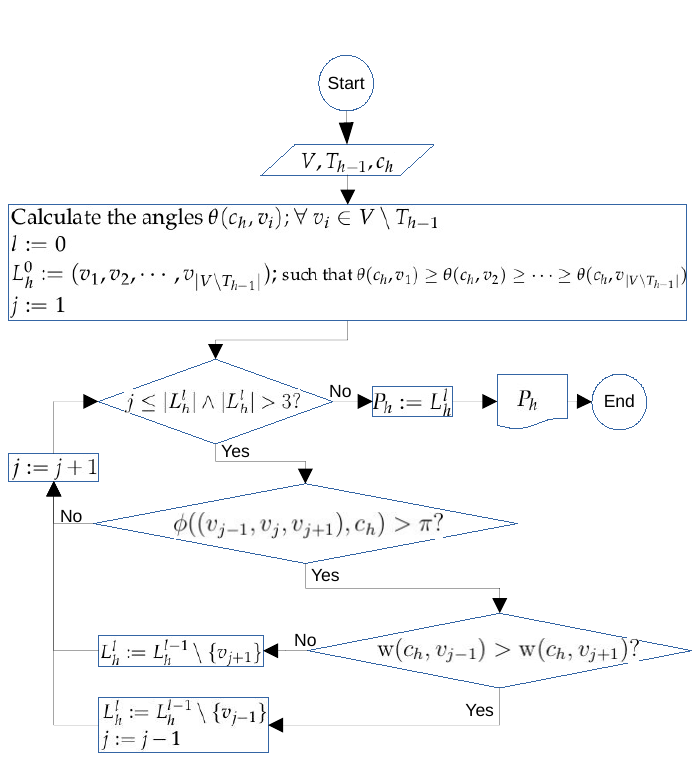
Figure 13. Inner convex hull algorithm flowchart.